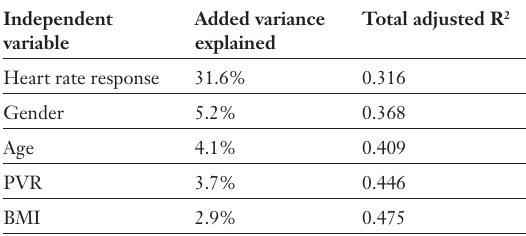
Predictors of maximal exercise capacity in 51 heart trans- plant recipients. PVR: pulmonary vascular resistance; BMI: body mass